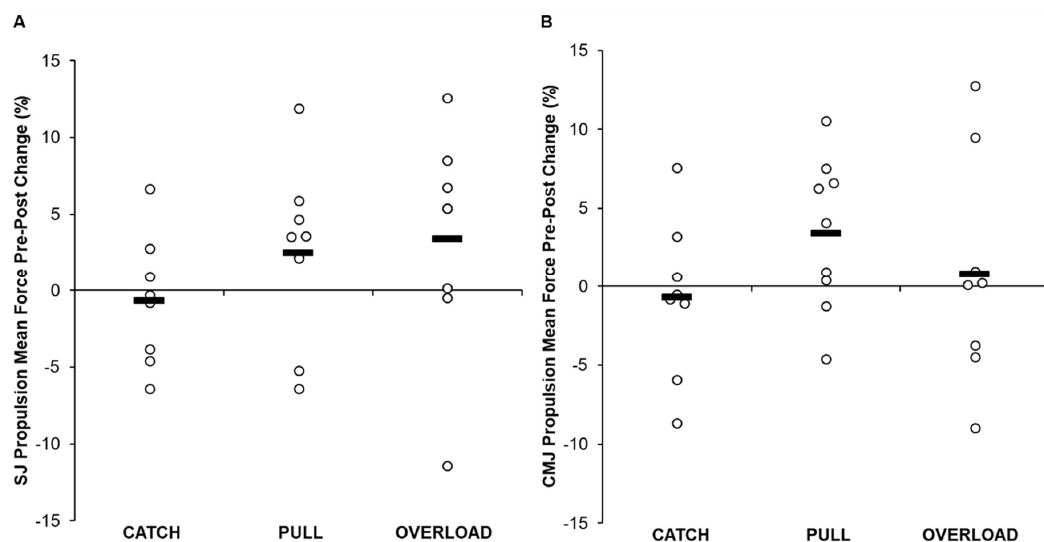
Figure 3. Pre- and post-intervention individual changes in squat jump ( A ) and countermovement jump ( B ) propulsion mean force. Bold line denotes group average and open circles denote individual changes.